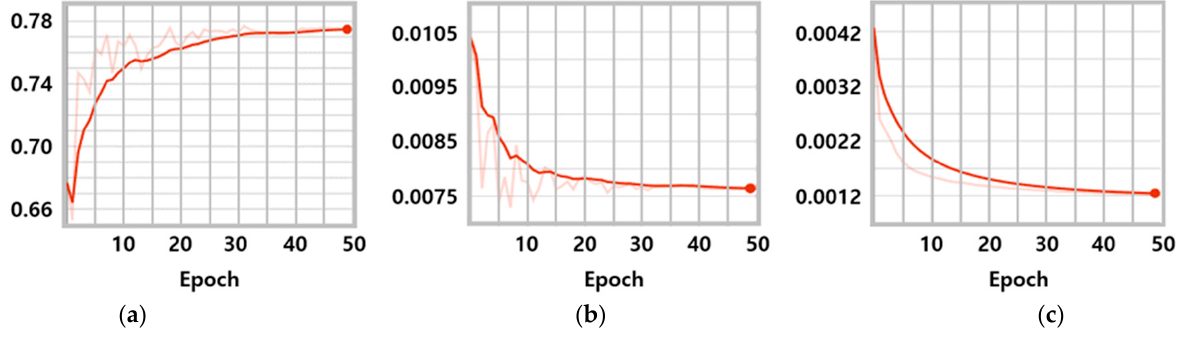
Figure 7. Training results obtained on the validation set for 50 epochs, ( a ) mAP@[0.5:0.95] curve; ( b ) curve of box loss; ( c ) curve of objectness loss.